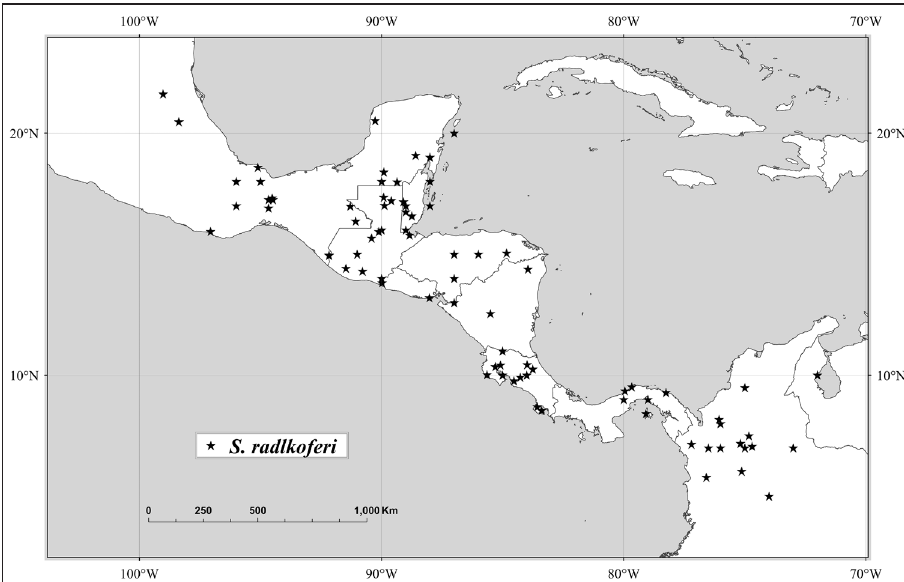
Figure 23. Distribution of Spondias